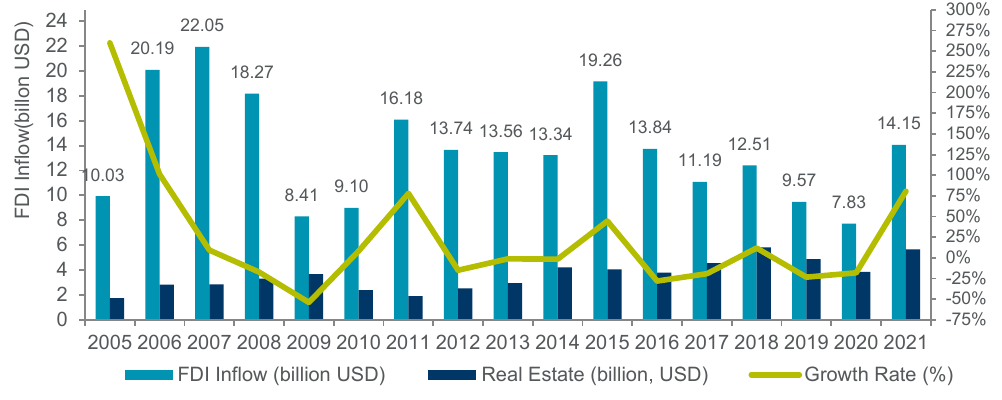
Figure 5 Foreign Direct Investment (2005-2021), Economy of Trade, 2022